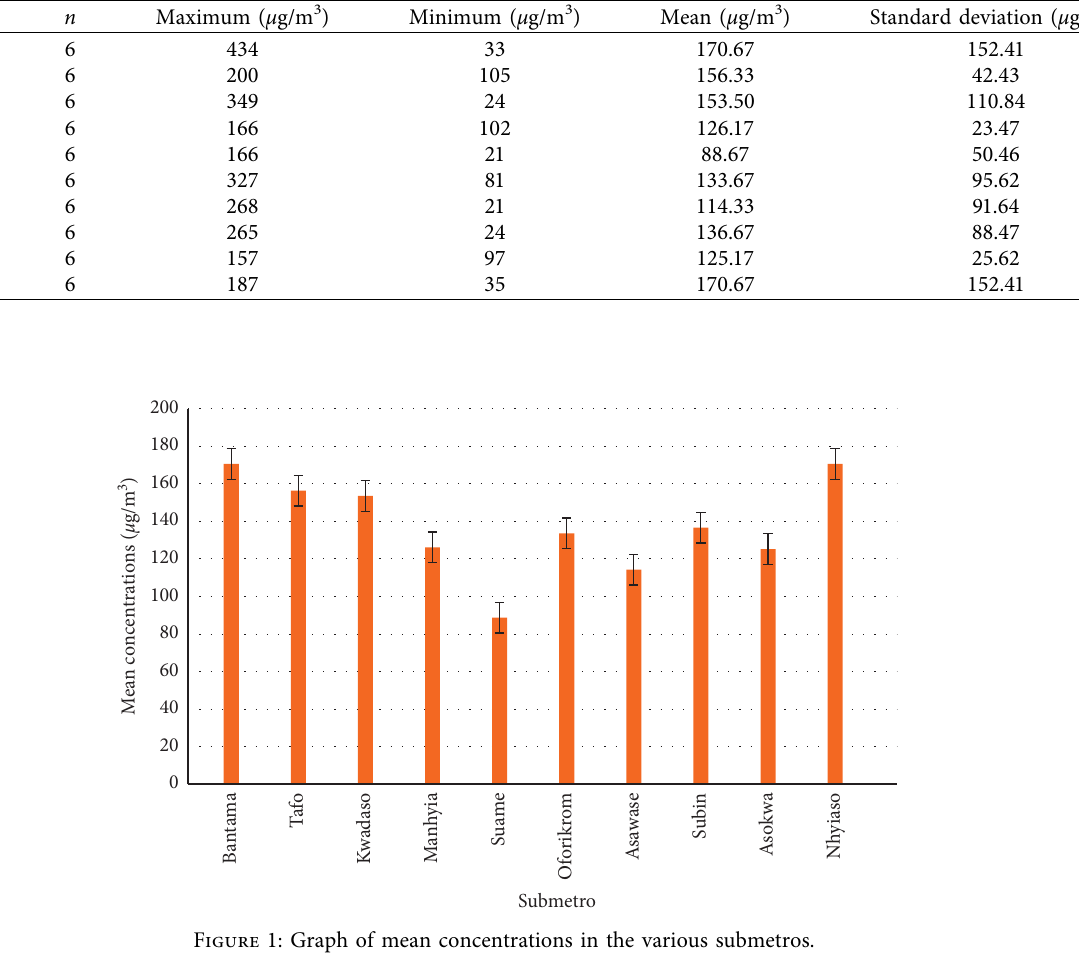
Table 1: Levels of formaldehyde and hazard quotients of the various salons in the submetros.